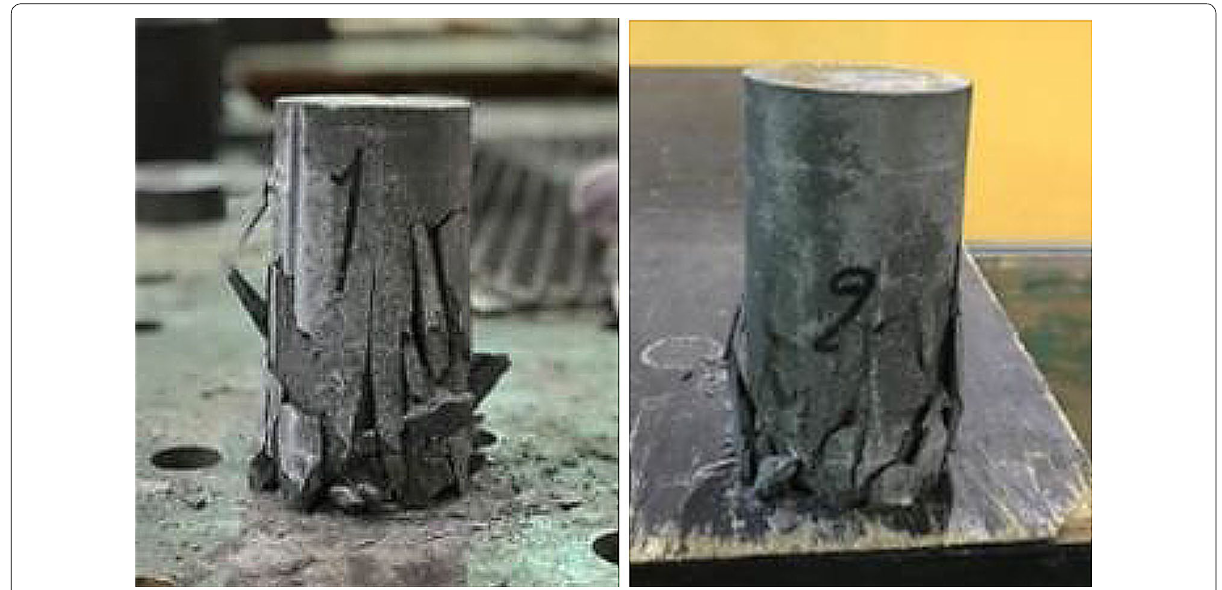
Fig. 12 Formation of cracks and UHPFRC with 5D steel fibers (T2) at failure of the compression